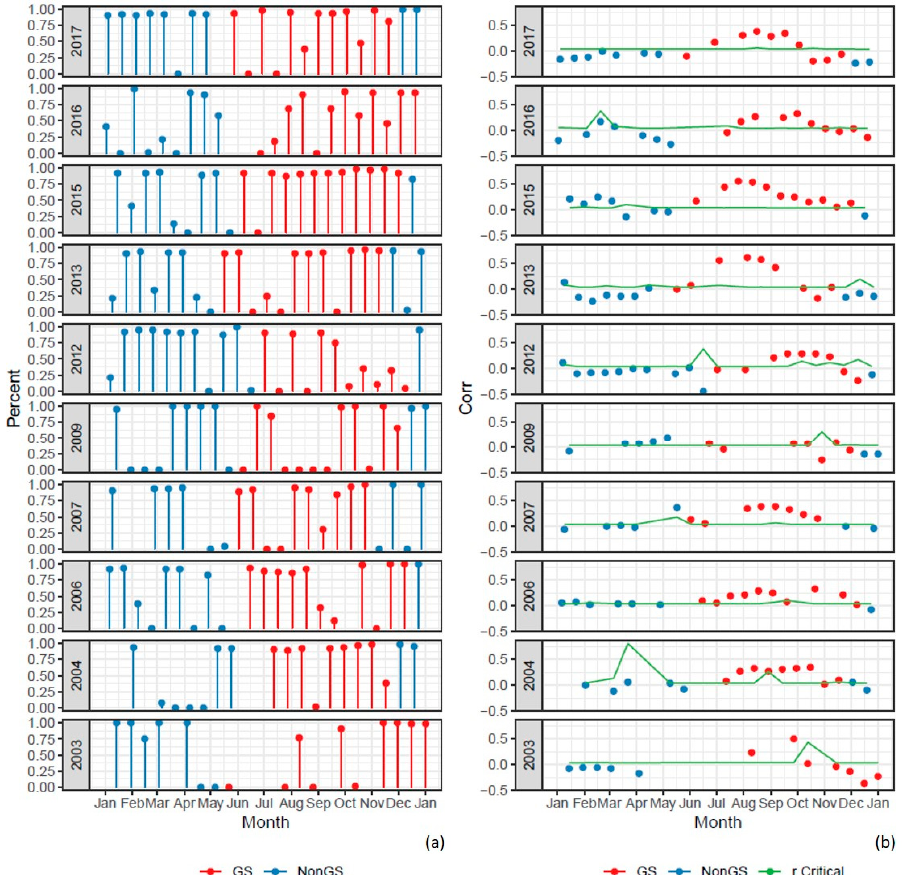
Figure 4. The spatial ( y -axis) and temporal ( x -axis) availability of Landsat 7 images ( a ) and the general correlation between clear-sky NDVIs and the corresponding annual yields ( b ) for site J. The red/blue colours of the dots indicate the image acquisitions dates were in the farmer-reported wheat seasons (GS)/non-farming seasons (NonGS). The farmer-reported wheat seasons were defined using the farmer-provided sowing and harvest dates; The bar heights in ( a ) indicate the percentage of clear-sky pixels in each year; the positive correlation (r) was statistically significant when it is greater than its corresponding ‘r Critical’ (green lines in panel ( b )).